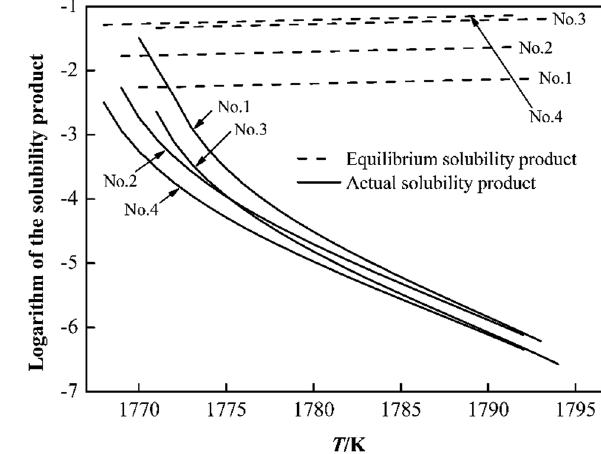
Figure 8: Logarithm of the solubility product as a function of temperature for MnS in the liquid phase at the solidification front.